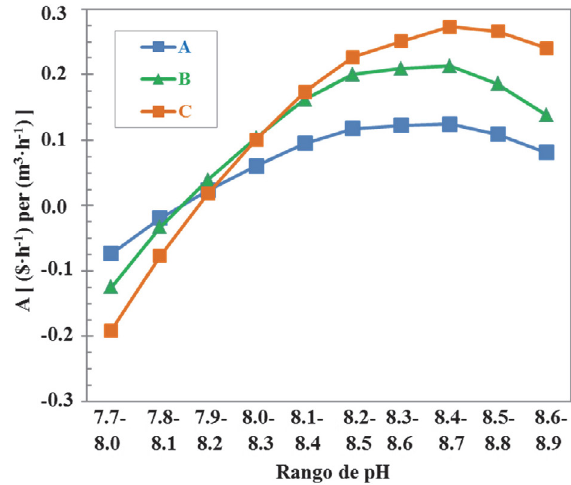
Figure 11 . Interaction of suspension pH with the economic benefit (A, $ · h –1 per m 3 · h –1 ), regarding ammonia losses and nickel precip- itation reagent consumption.